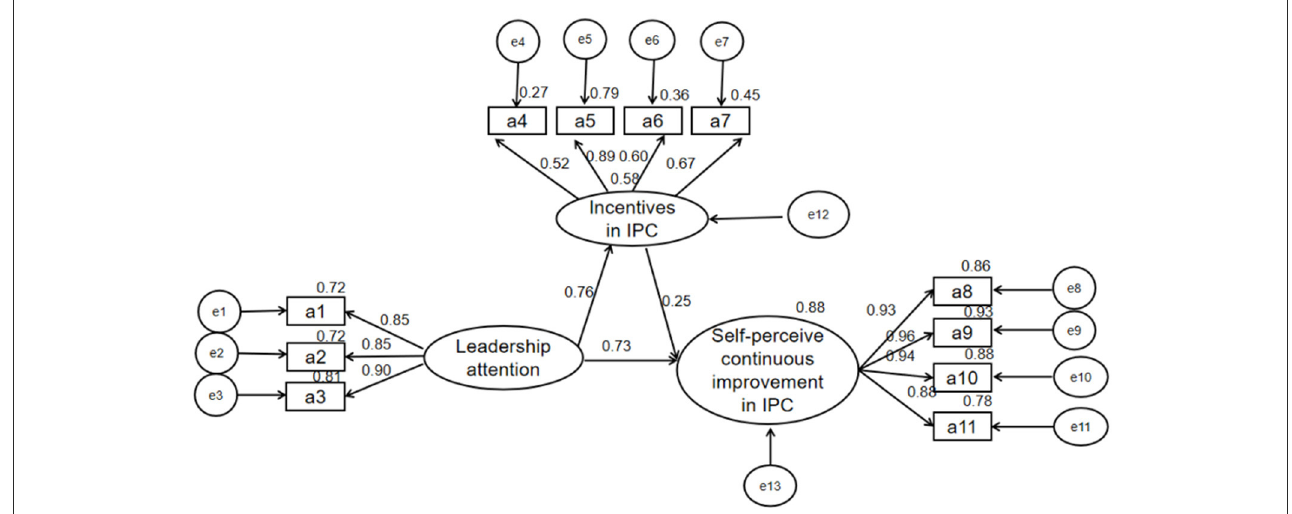
FIGURE2 Mediating model of incentives between leadership attention and self-perceived continuous improvement in IPC.